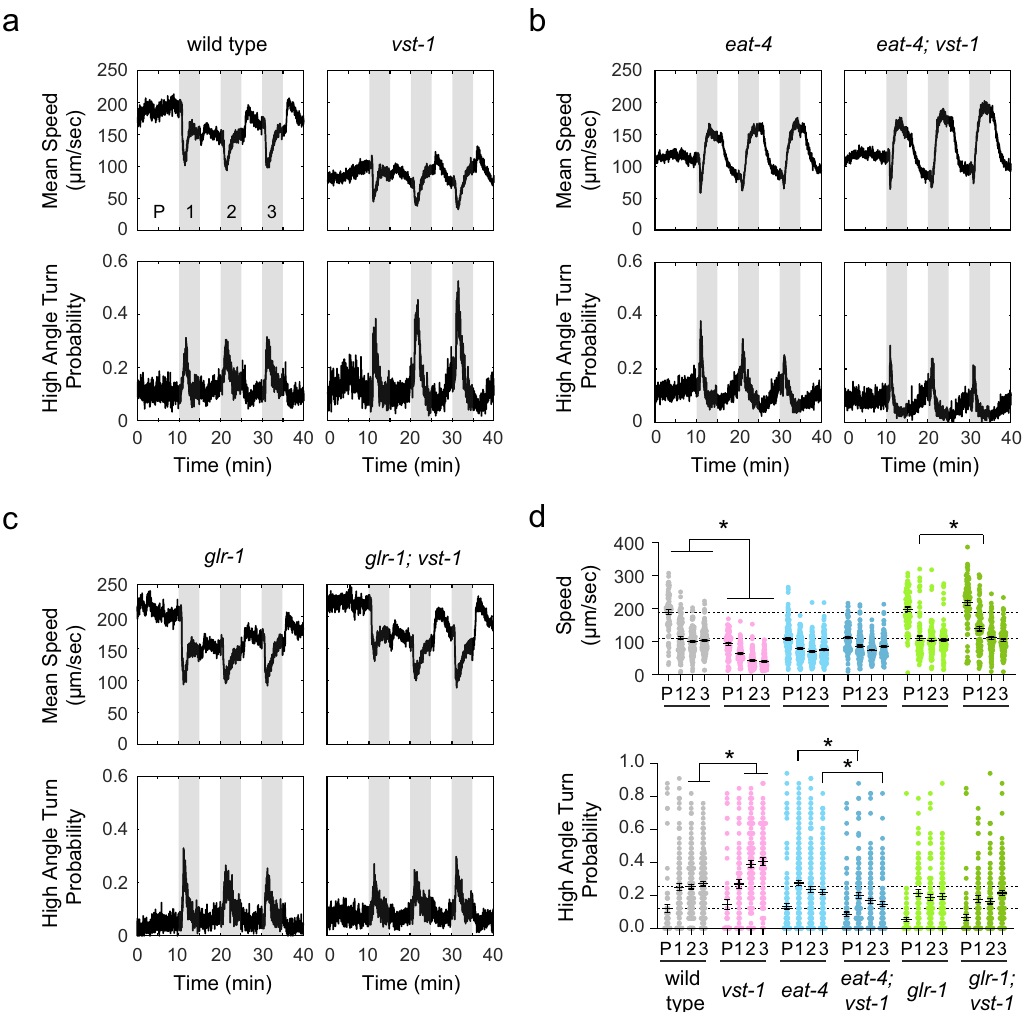
Fig. 5 Loss of VST-1 disrupts acute behavioral responses to CO 2 in a manner than requires GLR-1/AMPAR and EAT-4/VGLUT. a Instantaneous speed and probabilities of executing a high-angle turn of wild-type and vst-1 animals in response to three pulses of CO 2 . Pulses of CO 2 are labeled numerically and the pre-stimulus period is labeled ‘ P. ’ Traces in this panel and all other panels show the mean of measurements taken from at least eight independent trials of 30 – 60 animals. b Mean instantaneous speed and turn probabilities of eat-4 and eat-4; vst-1 mutants. c Mean instantaneous speed and turn probabilities of glr-1 and glr-1; vst-1 mutants. d Summary data from experiments shown in a – c . Dot plots show mean speeds and turn probabilities ± SEM of different strains during the pre-stimulus period (P) and after each presentation of CO 2 (labeled 1 – 3). The number of tracks analyzed ( n ) for mean speed during each period (P, 1, 2, and 3) are: 74, 105, 144, and 159 (wild type); 62, 79, 98, and 90 ( vst-1 ); 147, 166, 151, and 163 ( eat-4 ); 115, 130, 121, and 110 ( eat-4; vst-1 ); 73, 85, 90, and 95 ( glr-1 ); and 79, 84, 99, and 131 ( glr-1; vst-1 ). The number of tracks analyzed ( n ) for high-angle turn probability during each period (P, 1, 2, and 3) are: 74, 98, 145, and 158 (wild type); 62, 72, 100, and 90 ( vst-1 ); 147, 166, 155, and 170 ( eat-4 ); 115, 131, 120, and 107 ( eat-4; vst-1 ); 73, 85, 93, and 97 ( glr-1 ); and 79, 84, 102, and 127 ( glr-1; vst-1 ). Dashed lines indicate the means of wild type during periods P and 1. * P < 0.05 for comparisons between genotypes during the same period determined by a Kruskal – Wallis test and corrected for multiple comparisons via Dunn ’ s test. Only statistical comparisons between genotypes shown in the same panel in a – c are indicated here for simplicity. Statistical comparisons between genotypes shown in different panels (e.g., comparison between vst-1 and eat-4; vst-1 ) and exact P -values for all comparisons are shown in Supplementary Table